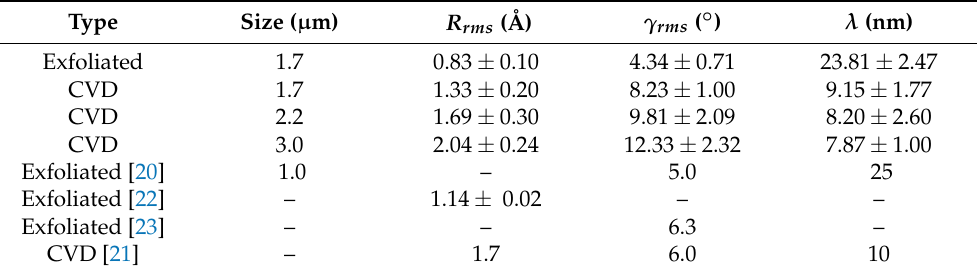
Table 1. Summary of results compared to literature values. R rms is the root-mean-square amplitude of the corrugations, γ rms the root-mean-square inclination, and λ the corrugation wavelength. In total, six exfoliated samples were measured, whereas the CVD data is from two different samples. More than 20 measurements in independent sample areas were carried out for each parameter